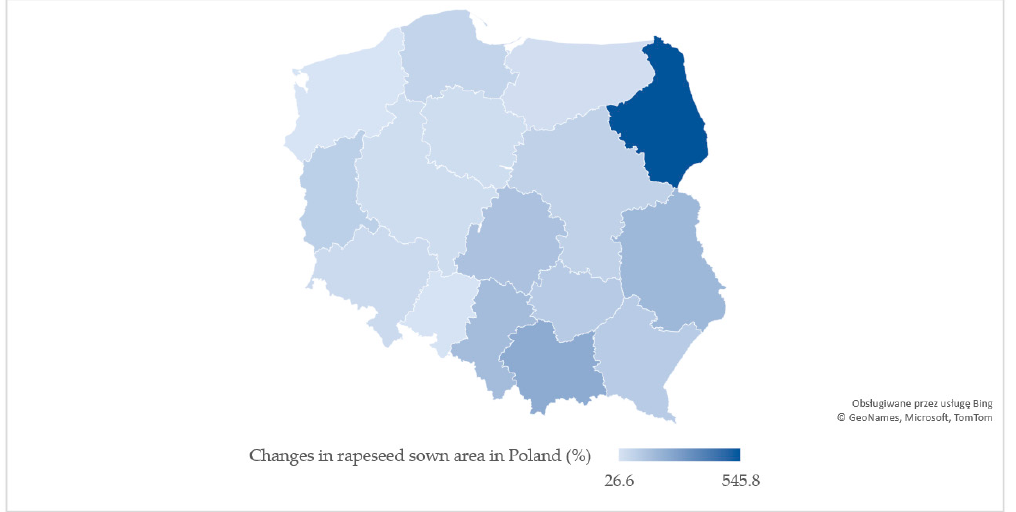
Figure 4. Changes in rapeseed production in Poland in 2005–2020 (%). Source: own elaborations based on rapeseed market